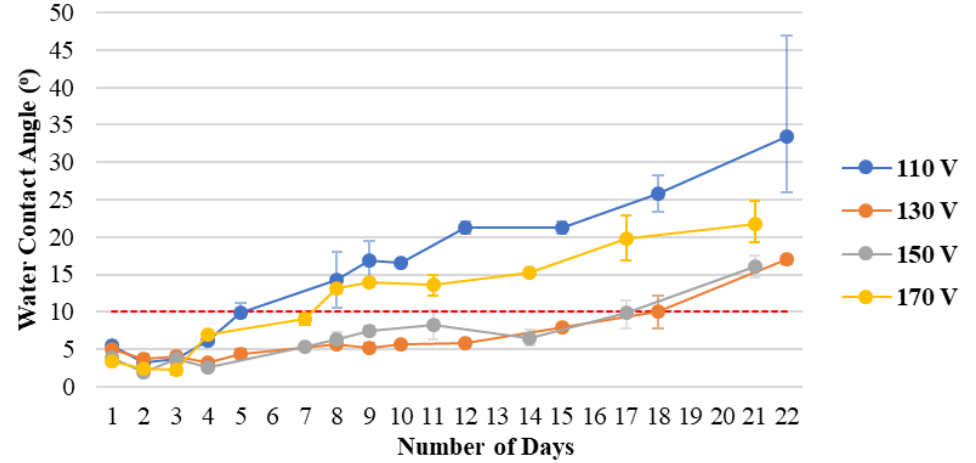
Figure 3. Hydrophilicity persistence of plasma-treated PC substrates at different voltages.